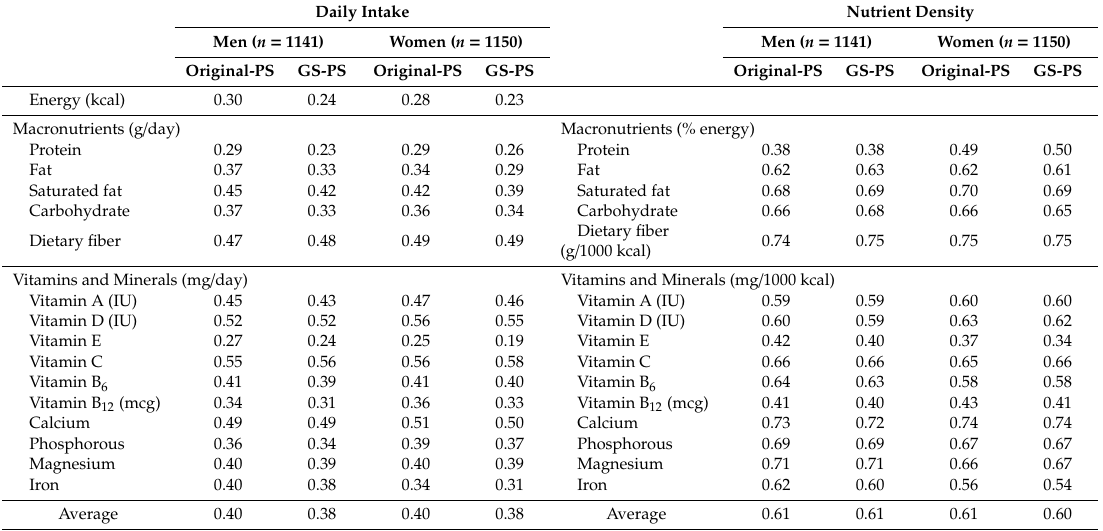
Table 5. Pearson correlation coe ffi cients among daily nutrient intakes from 24 h dietary recalls and those from quantitative food frequency questionnaire using either an original-portion size (original-PS) or a gender specific-portion size (GS-PS) in the calibration study of the Multiethnic Cohort. 1. Daily Intake Nutrient